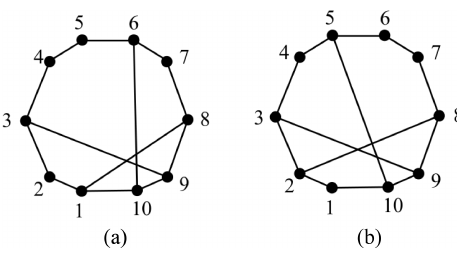
If the 3C of the two graphs is the same, then the two graphs are judged to be isomorphic; otherwise, they are judged to be non-isomorphic. The main steps of the detection algorithm are illustrated as